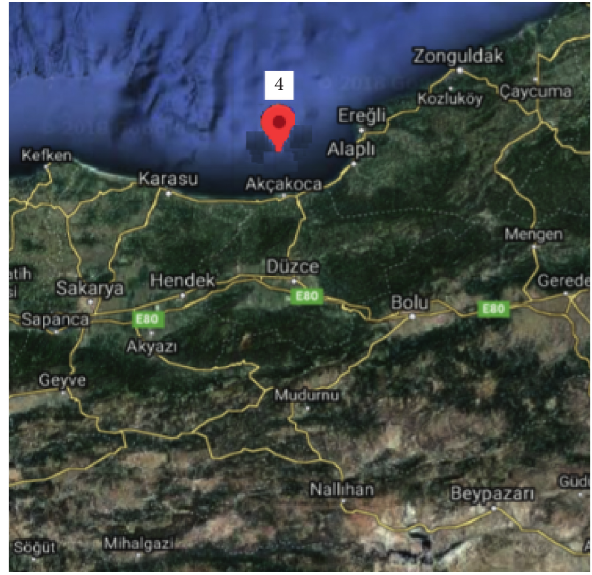
Figure 5: Sample collection from Duzce Coast of Black Sea (41 ° 19 ′ N, 31 ° 13 ′ E).